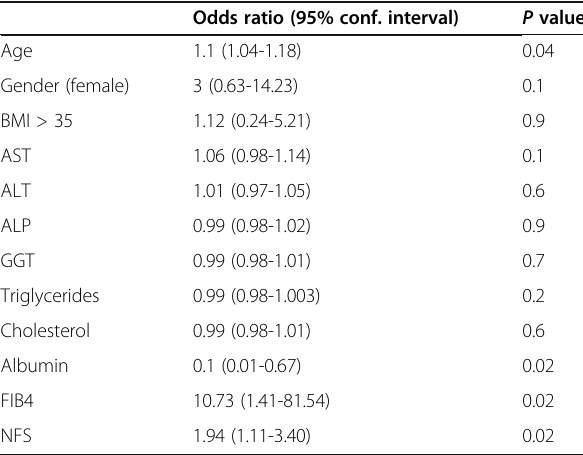
Table 3 Predictors of higher grades of fibrosis in simple steatosis group (NAS score ≤ 4) (n = 31) Odds ratio (95% conf.